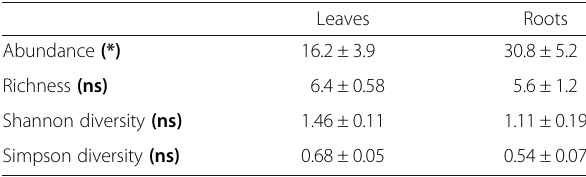
Table 2 Diversity indices for endophytic fungi inhabiting leaf and root tissues in Aristolochia